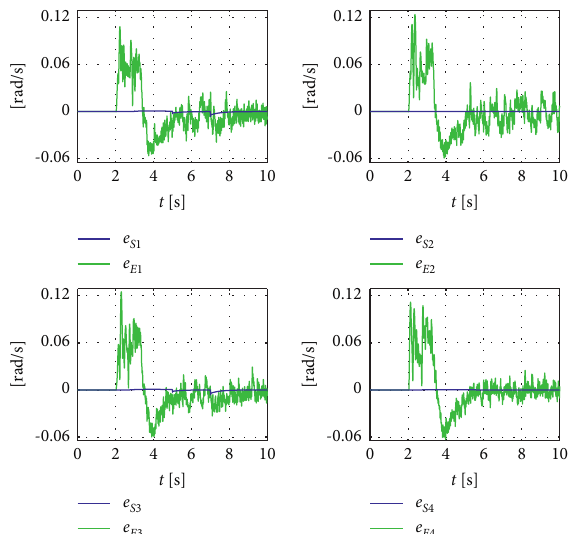
Figure 18: Tracking errors of the system in closed loop for ω . In these graphics, the tracking errors associated with the simulation results are denoted as e S , e S , e S , and e S , while the tracking errors related to the experimental results are represented by e E 1 2 3 4